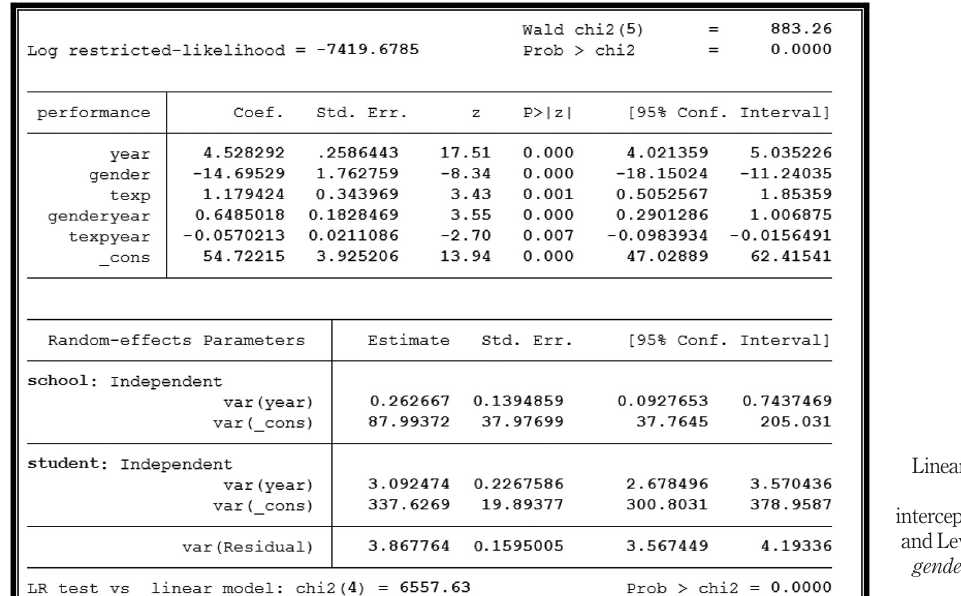
Figure 12. Linear trend